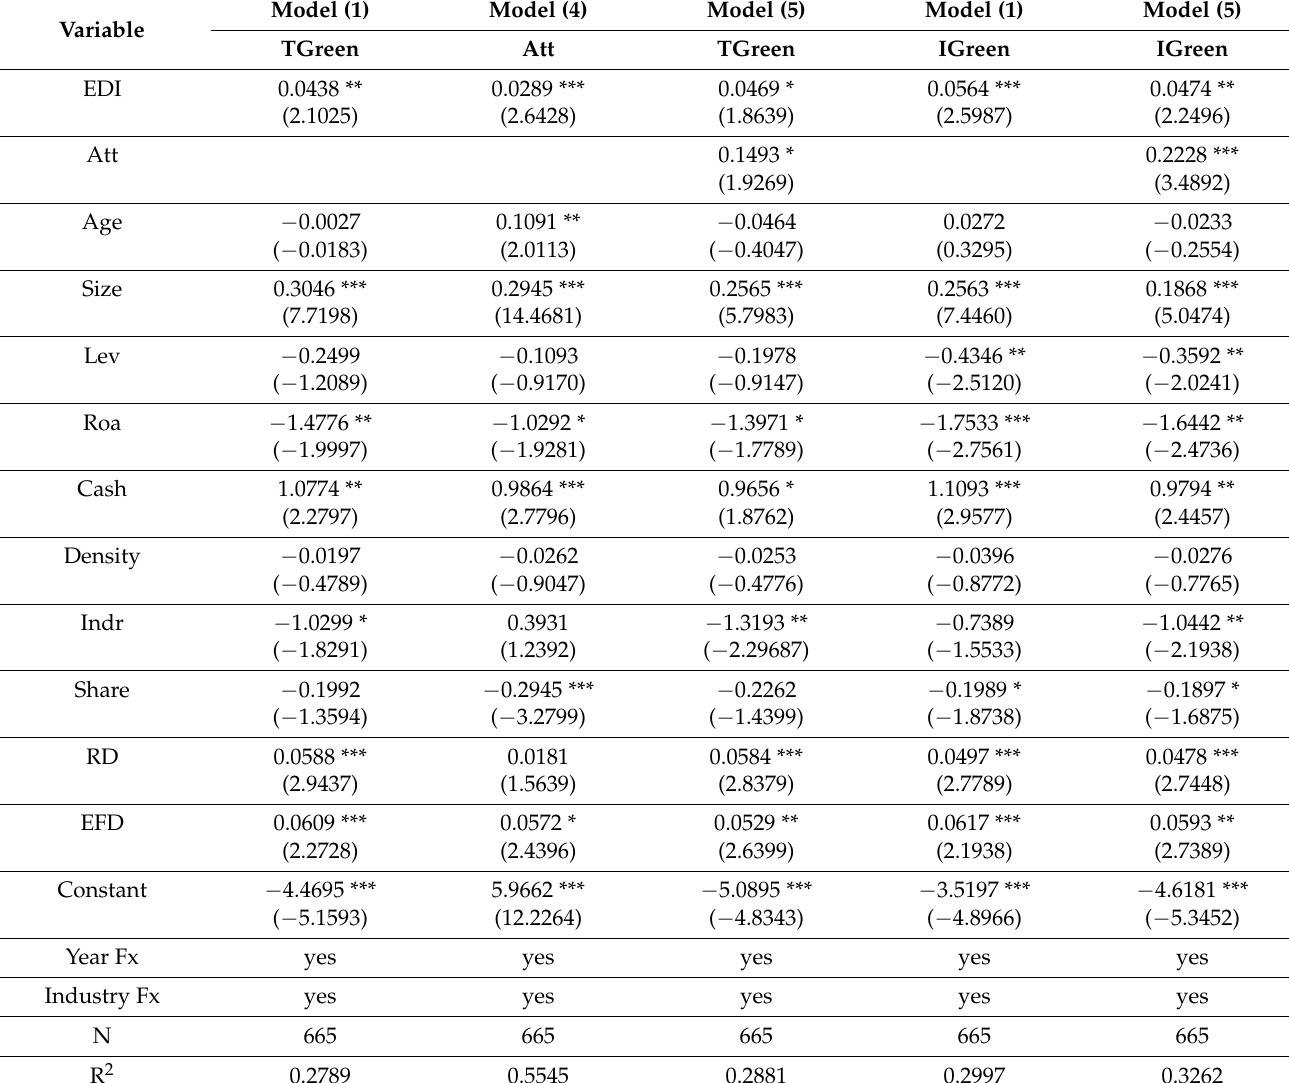
Table 6. Mediating effect of public